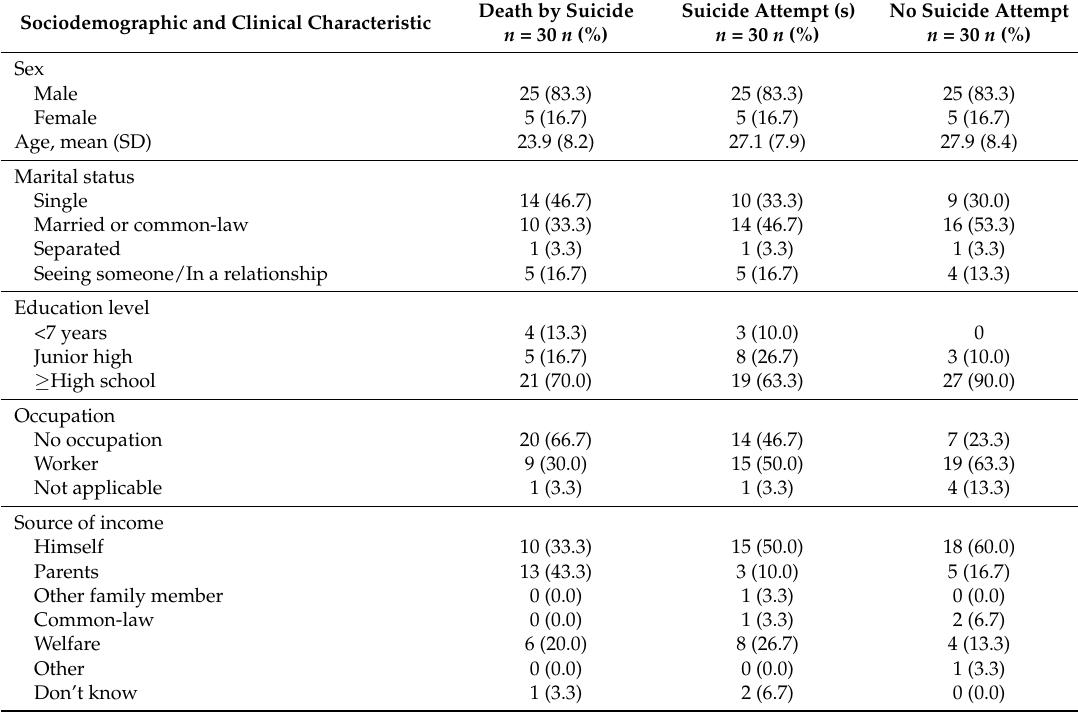
Table 2. Sociodemographic and clinical characteristics of the study